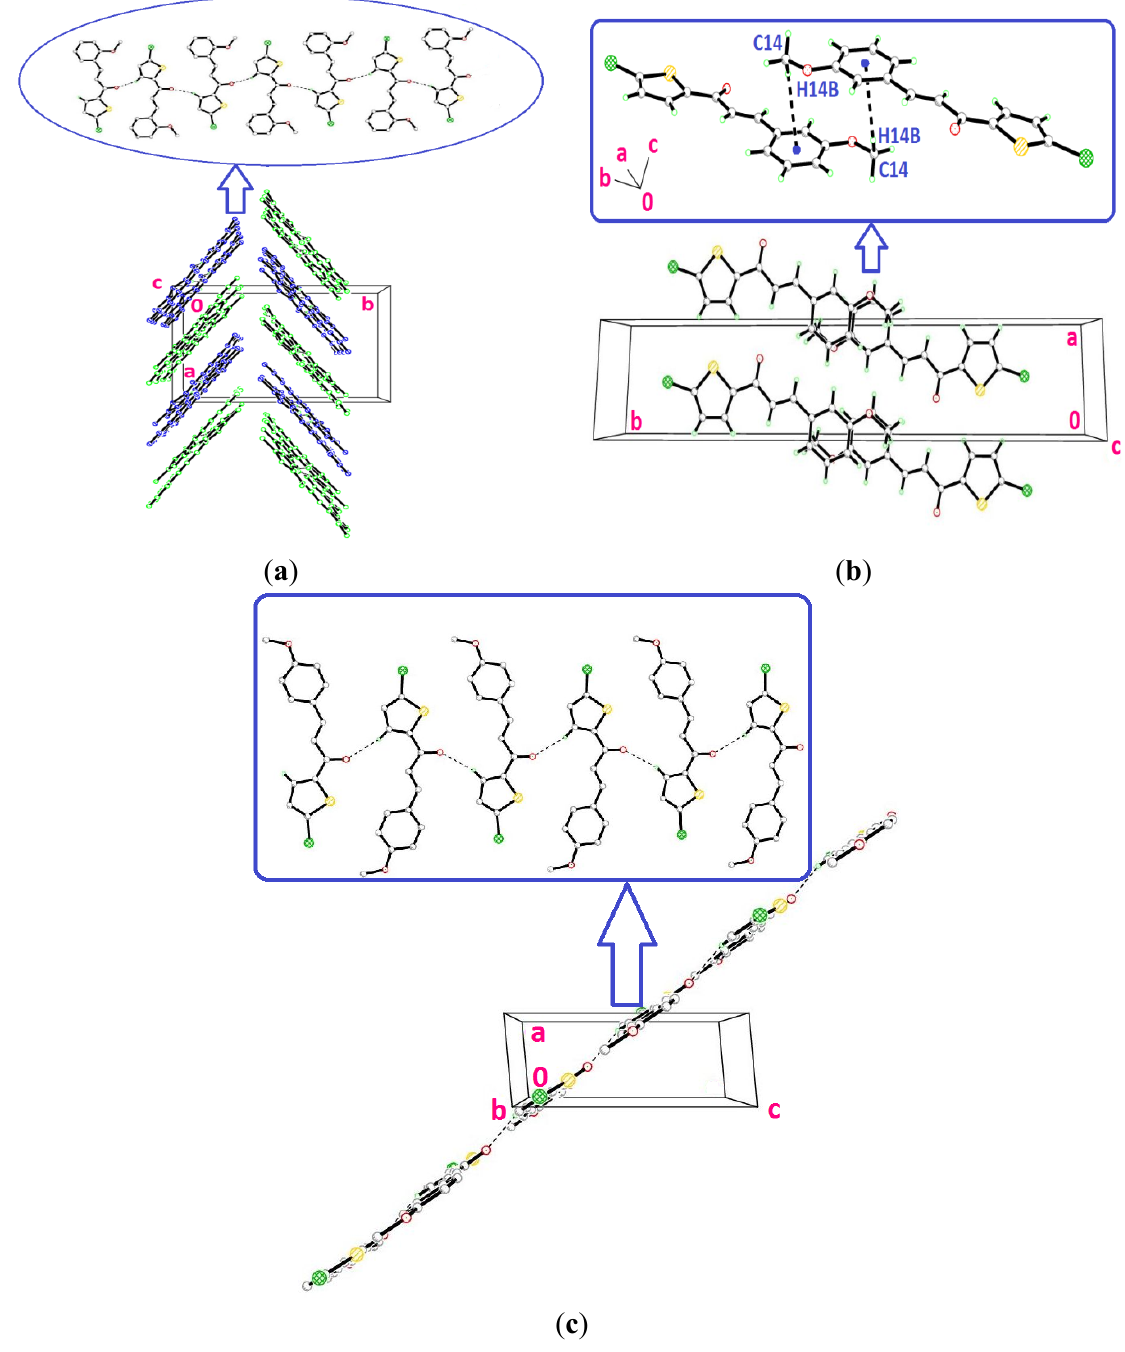
Figure 8. ( a ) Crystal structure of 4d with the linkage of molecules A and D represented in blue and the linkage of molecules B and C in green, propagating along the c -axis. Hydrogen bonds not involved in the interactions have been omitted for clarity. Dashed lines are shown as intermolecular hydrogen bonds. ( b ) Packing diagram of 4e , showing the C—H··· π interactions involving the centroids of the benzene ring. Dashed lines represent the C—H··· π interactions. ( c ) Crystal structure of 4f , displaying the infinite chains running along the (201) plane. Intermolecular hydrogen bonds are represented as dashed